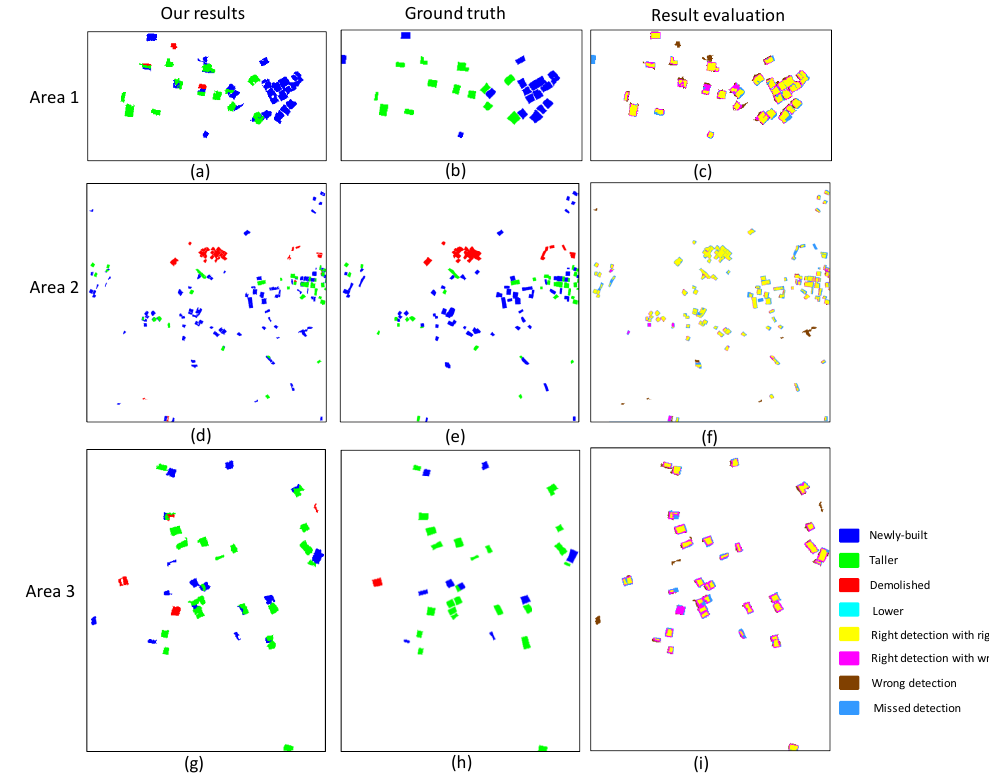
Figure 9. Results of the proposed method, ground truth, and the corresponding result evaluation. ( a , d , g ) are the results of Area 1, Area 2, and Area 3 with the proposed method, respectively. ( b , e , h ) are the ground truths of Area 1, Area 2, and Area 3, respectively. ( c , f , i ) are the corresponding result evaluations of Area 1, Area 2 and Area 3,